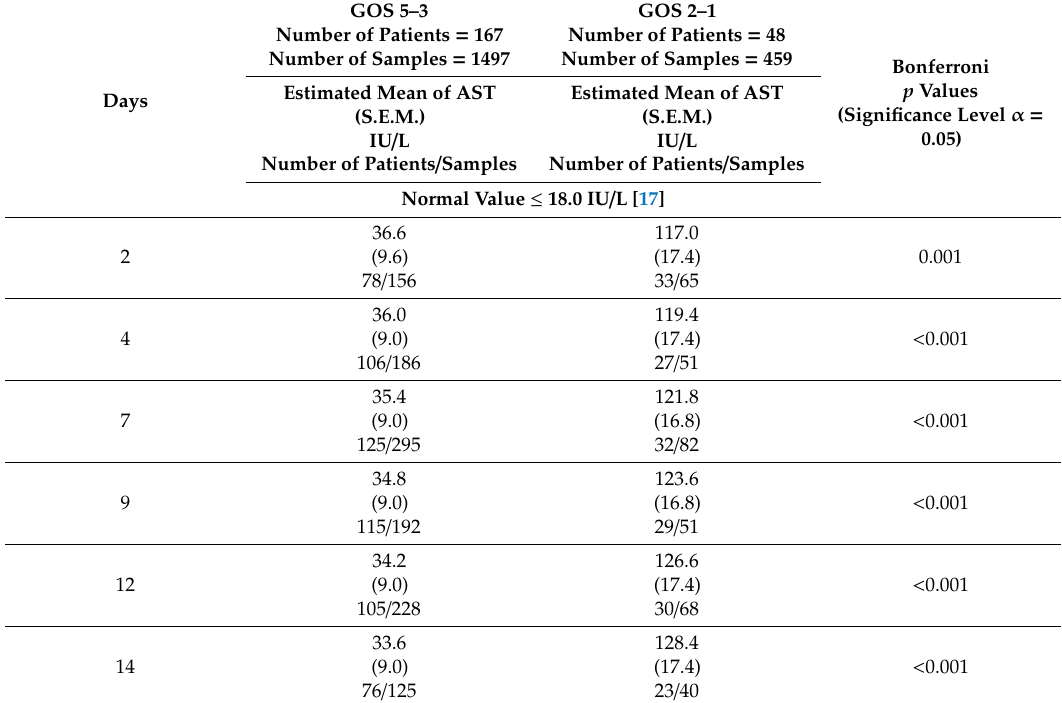
Table 1. Development of estimated means of AST catalytic activities in the CSF of patients following CNS haemorrhage with a GOS 5–3 and a GOS 2–1.